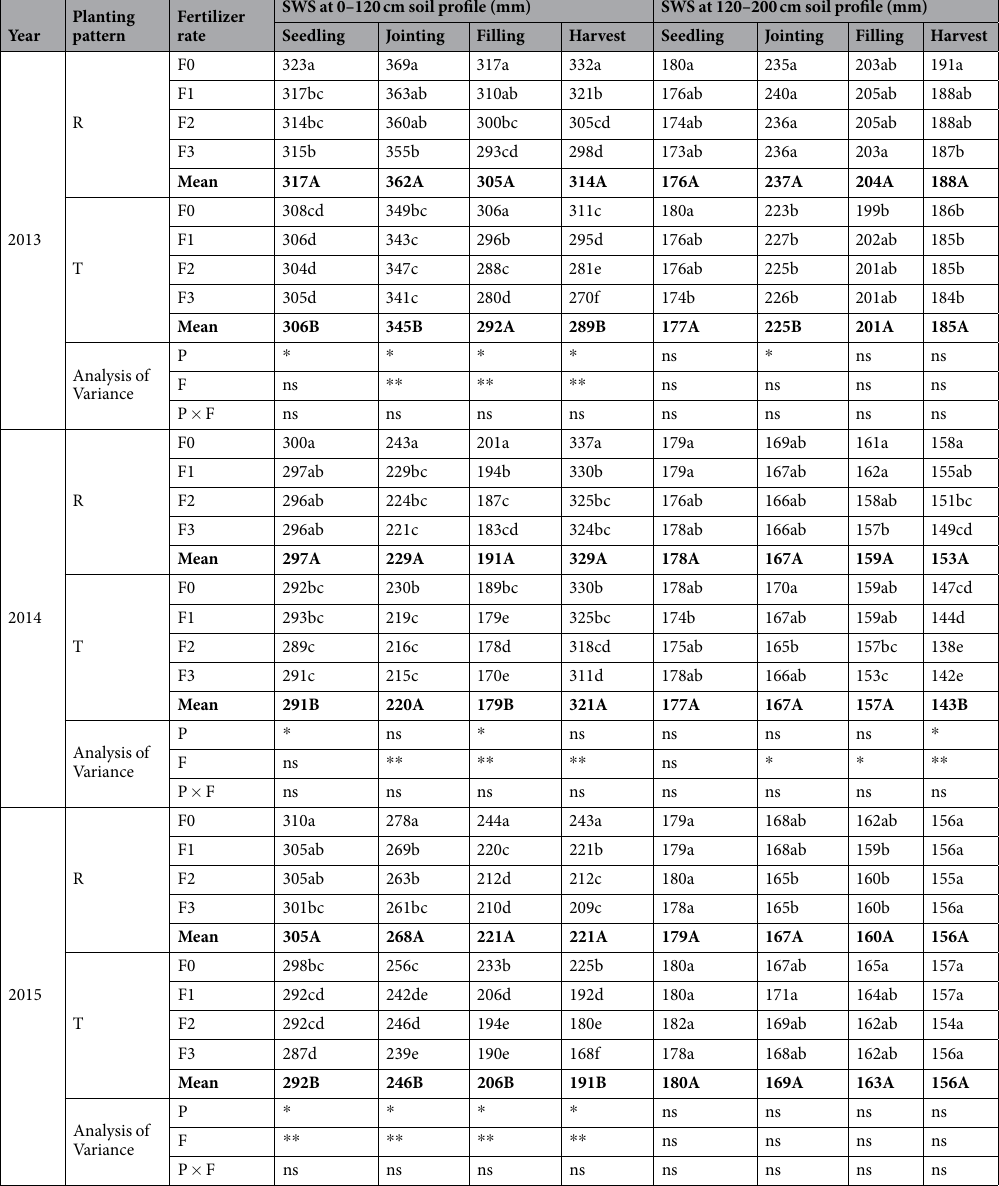
Table 1. Soil water storage (SWS, mm) at different growth stages according to the fertilizer rate and planting pattern during the foxtail millet growing seasons in 2013–2015. Within a column, means followed by the same letter for each year are not significantly different at the 0.05 probability level according to the least significant different test (LSD 0.05); lowercase and uppercase letters indicate comparisons among different treatments and between two planting patterns, respectively. ns denotes no significant different; * significant different at the 0.05 probability level; ** significant different at the 0.01 probability level; P is the planting pattern, F is the fertilizer rate. The same symbols and abbreviations are used in the other